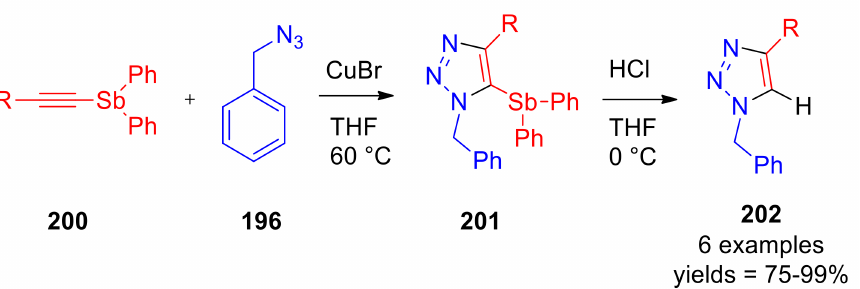
Scheme 66. Synthesis of C5-unsubstituted 1,2,3-triazoles 202 through 4-substituted 1-benzyl-5- diphenyl-stibano-1,2,3-triazoles 201 as